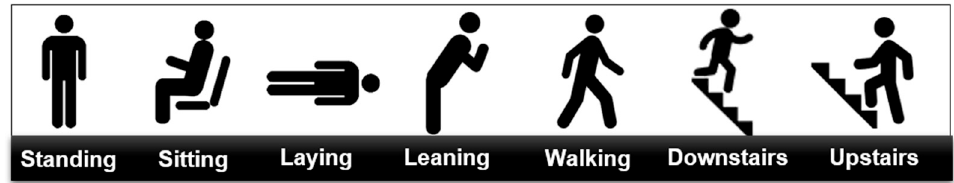
Figure 4. Studied activities and postures.